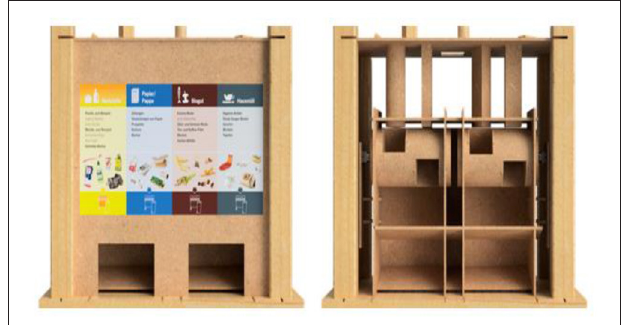
FIGURE 5 | Replication of a the learning tool “Garbage Separation Bot"” developed within a student